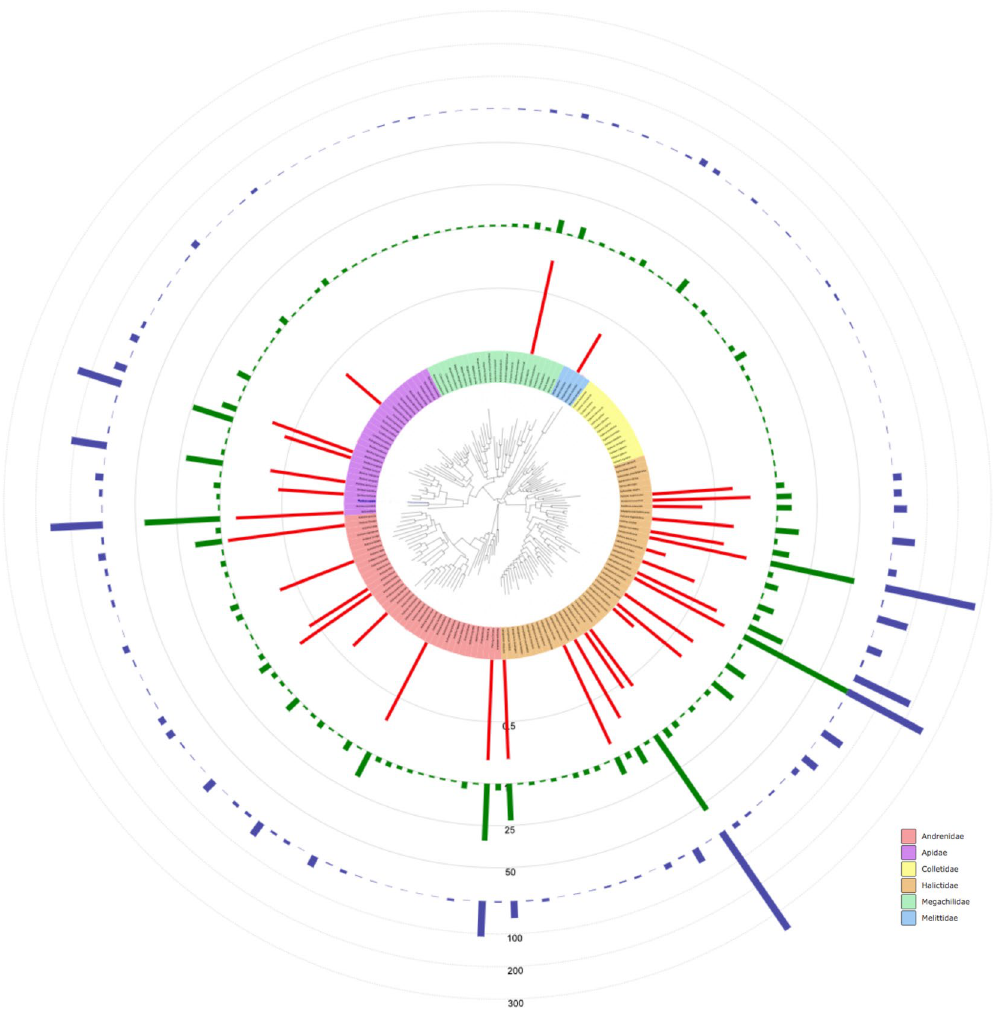
Figure 2. Approximately Maximum-Likelihood tree of species found in our study. Species are color-coded by family. Bars represent the abundance of each species (blue), the number of haplotypes (green) and the values of haplotype diversity only for species with n > 10